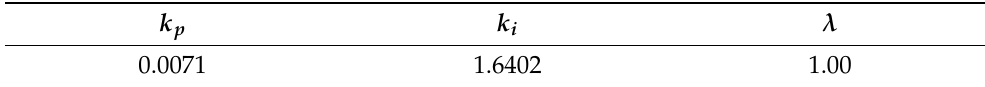
Table 2. Integer order controller